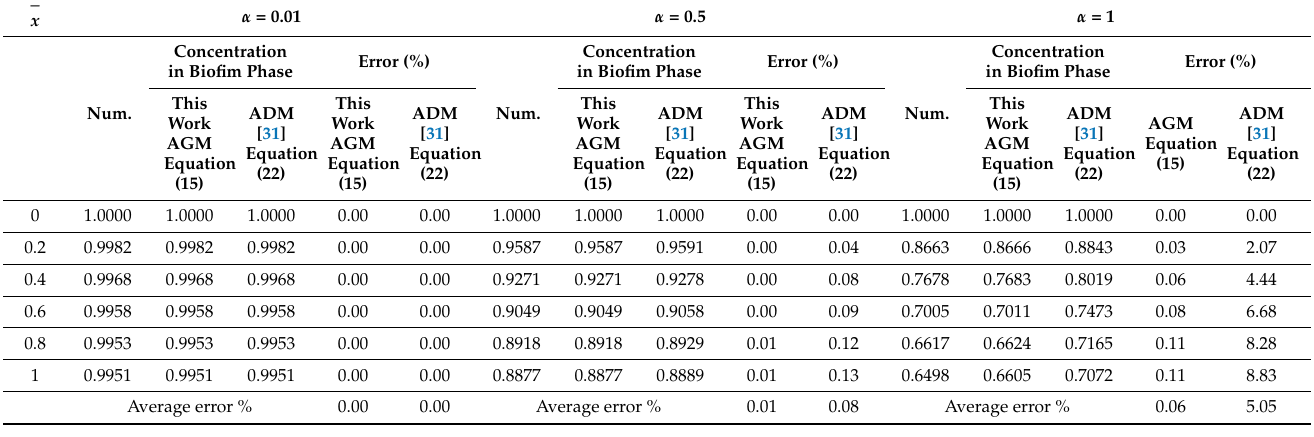
Table 1. Comparison between numerical and analytical results for the dimensionless NO concentra- tion of the biofilm phase c l ( x ) for various values of parameter α when β = 0.01.